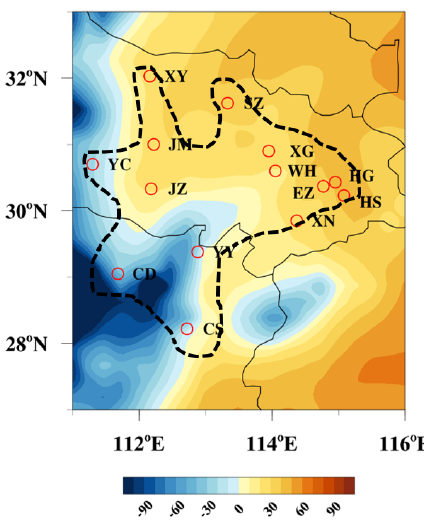
Figure 10. Spatial distribution of contribution rates of meteorolog- ical variations regarding PM 2 . 5 reductions based on WRF-Chem modeling experiments (contour, unit: %) in the THB outlined with black dashed line and surrounding regions for December of 2015–